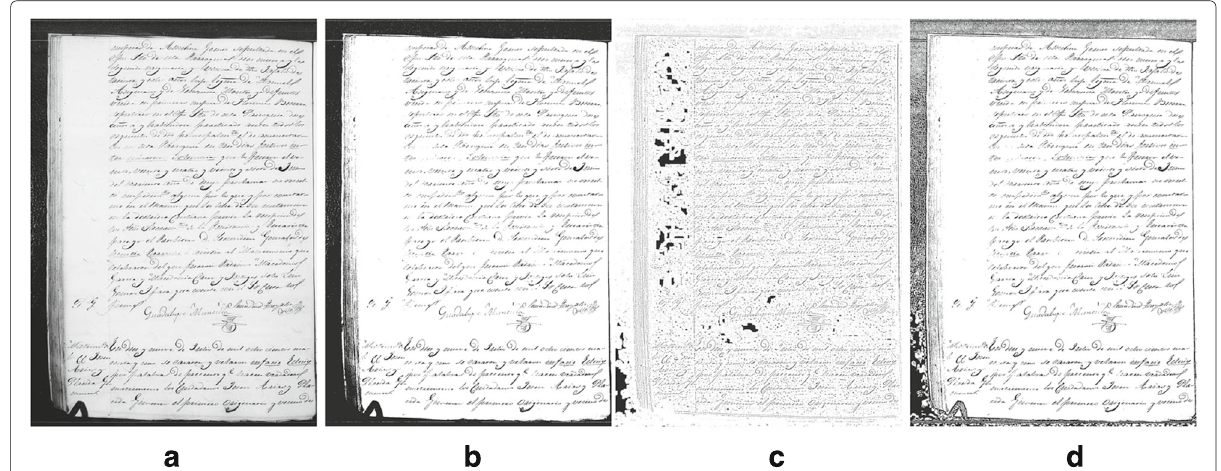
Fig. 2 a Input image. b Otsu’s binarization result. c Niblack’s binarization result. d Sauvola’s binarization